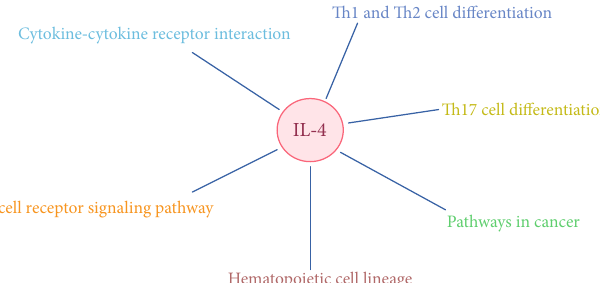
Figure 7: The correlation network between the key gene and KEGG pathways.